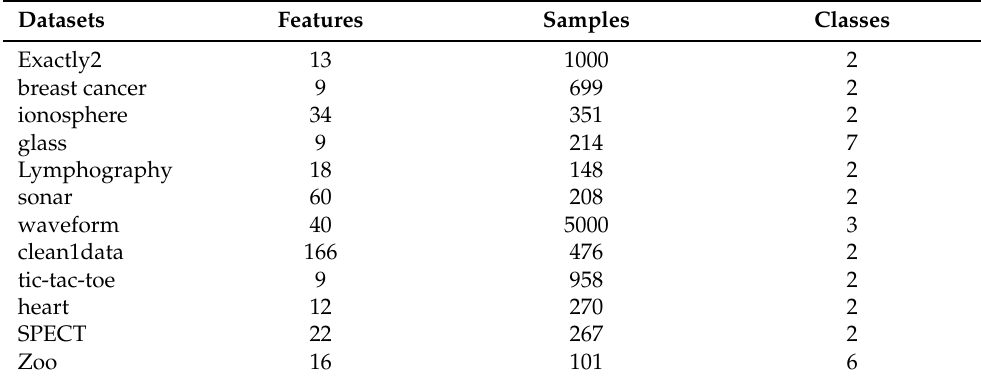
Table 7. Datasets